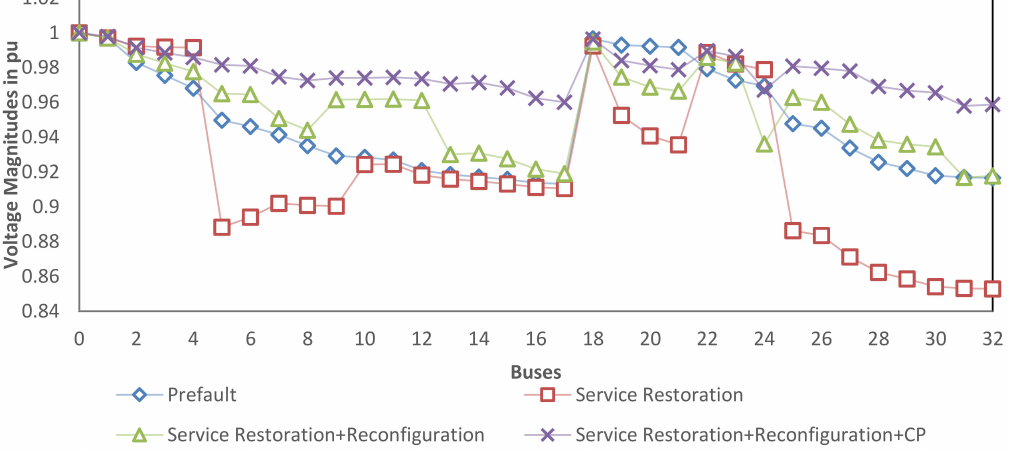
Figure 9. Bus voltage of test case 1 at MFC at zones 1 and 3. Table 4. Summary of results for test case 1 under MFC at di ff erent